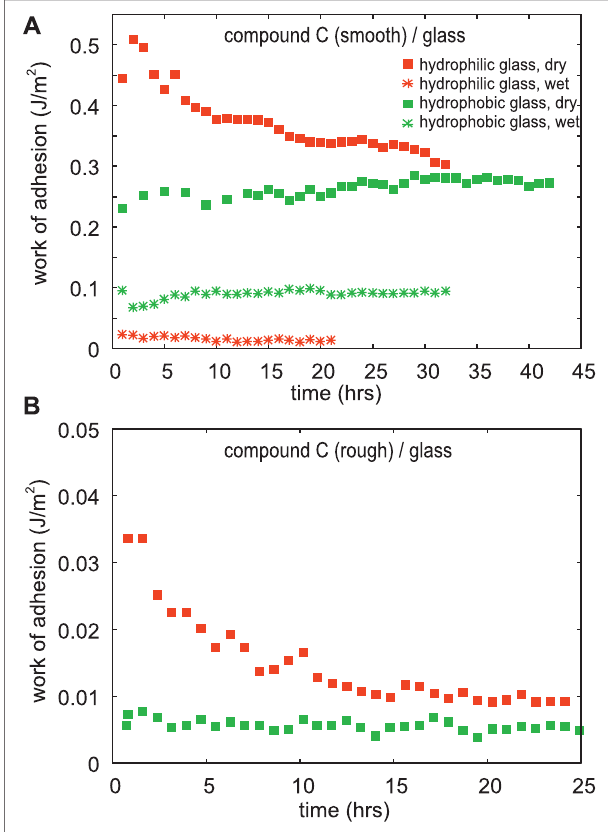
FIGURE 6 | The work of adhesion between a glass ball and the rubber compound C for dry contact (squares) and in water (stars). In (A) the rubber surface is smooth and cleaned with hot water just before start of the experiment. In (B) the rubber surface was roughened by sandpaper just before start of the experiment. The red symbols are for a glass ball cleaned withacetone and isopropanol.The green symbols are for asilanized glass